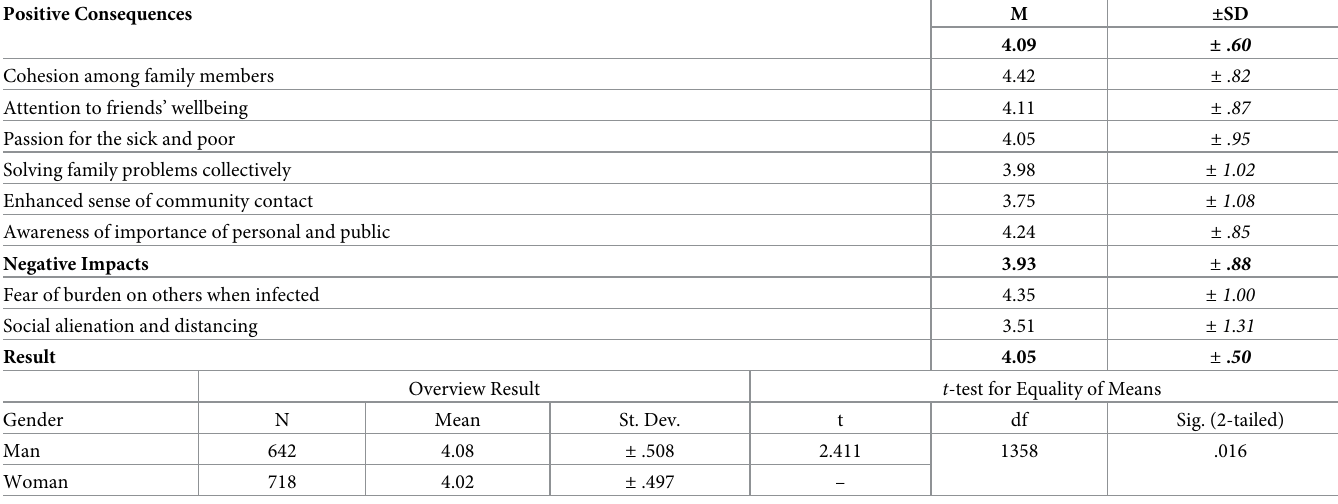
Table 4. Descriptive statistics for the impacts of COVID-19 on social and emotional aspects of students’ lives. Positive